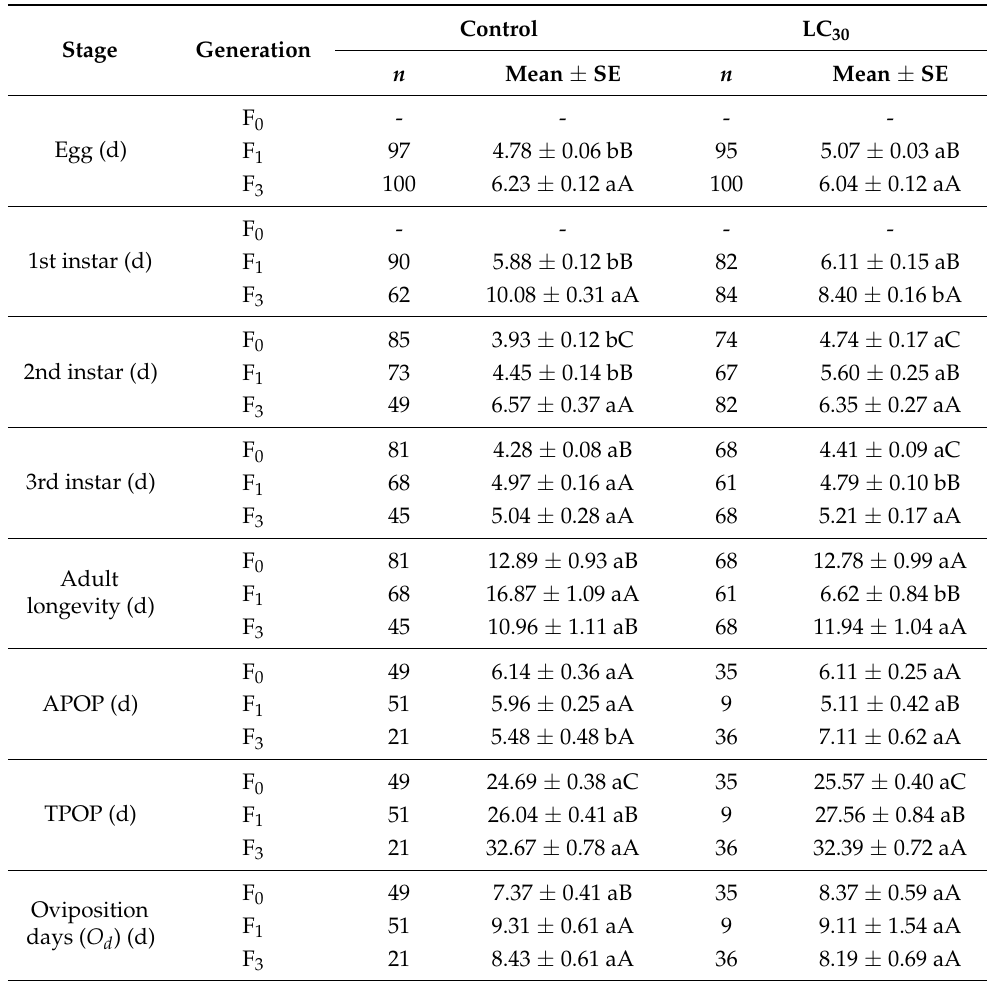
Table 1. Duration of each development stage, longevity, APOP, TPOP and oviposition days of P. marginatus in different generation exposed to LC 30 of